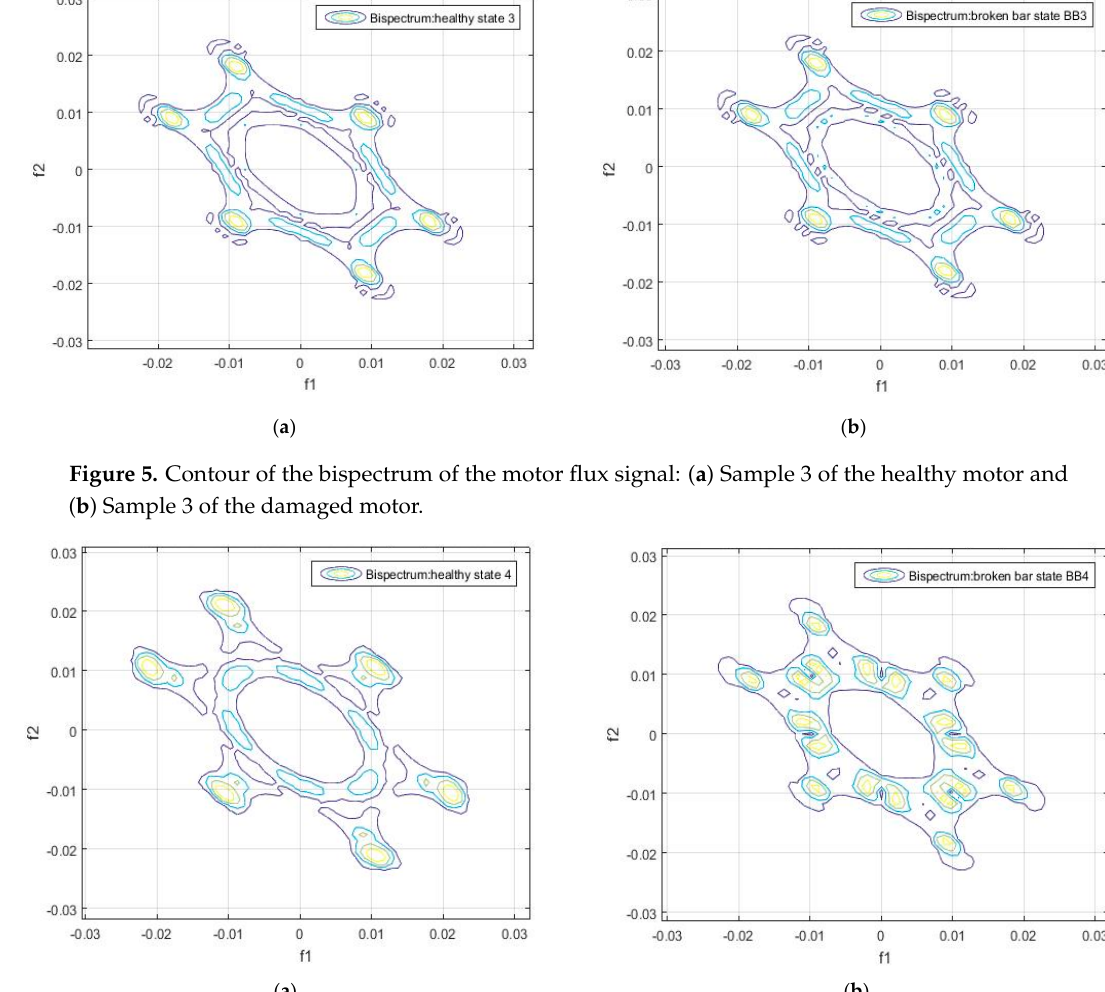
Figure 6. Contour of the bispectrum of the motor flux signal: ( a ) Sample 4 of the healthy motor, ( b ) Sample 4 of the damaged motor.